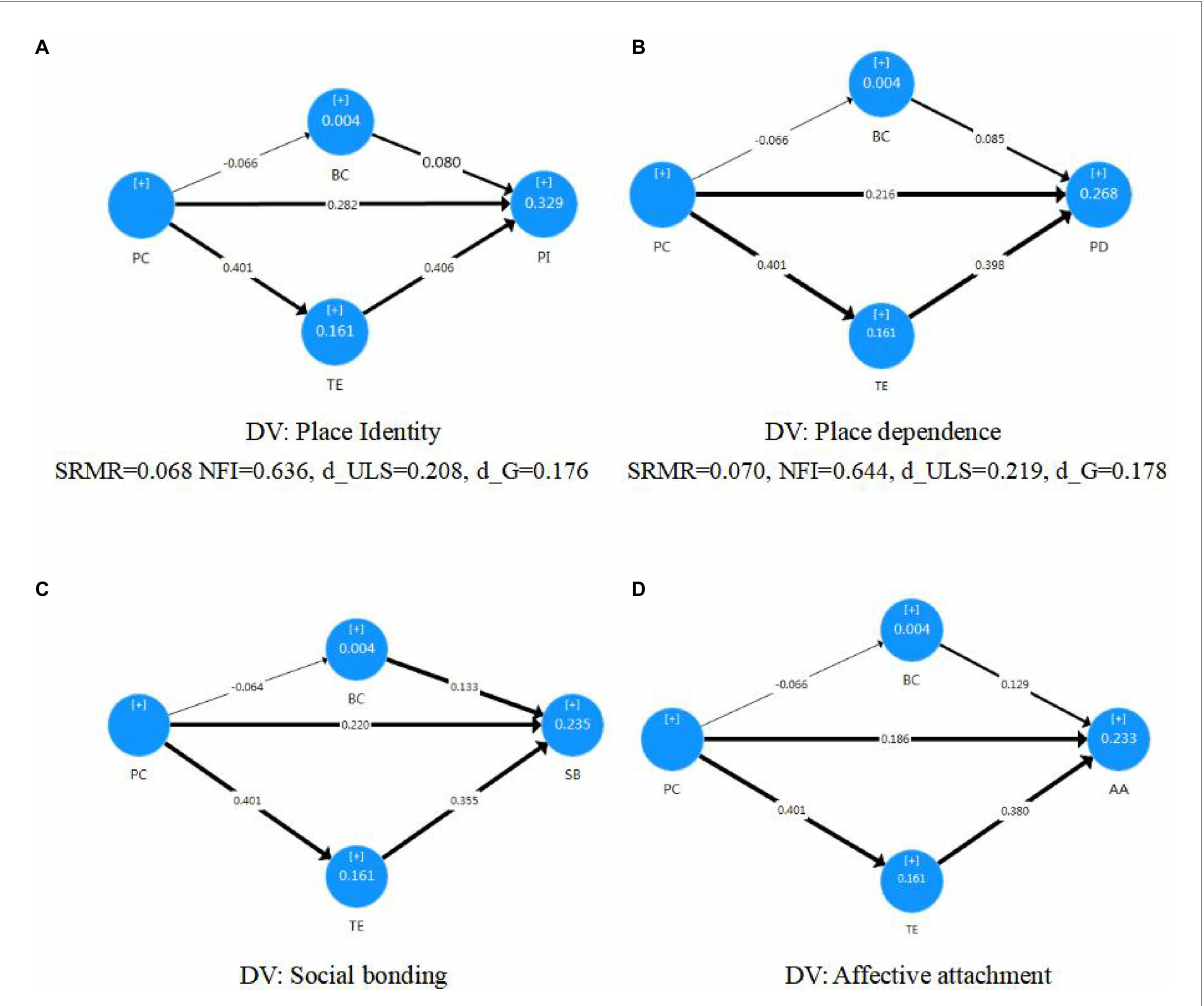
FIGURE 2 Structural models of relationships with standardized regression coefficients and R 2 values between perceived change and destination attachment: (A) Place identity, (B) place dependence, (C) social bonding, (D) affective attachment (bold paths are significant at p < 0.05 or p < 0.01 level, numbers in the circles are R 2